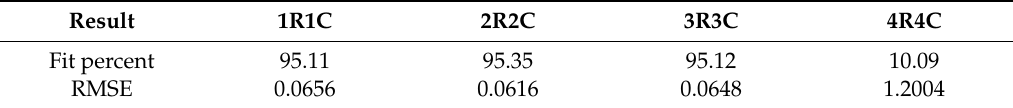
Table 4. Fifteen-minute prediction results for expirment A. Table 5. Thirty-minute prediction results for experiment